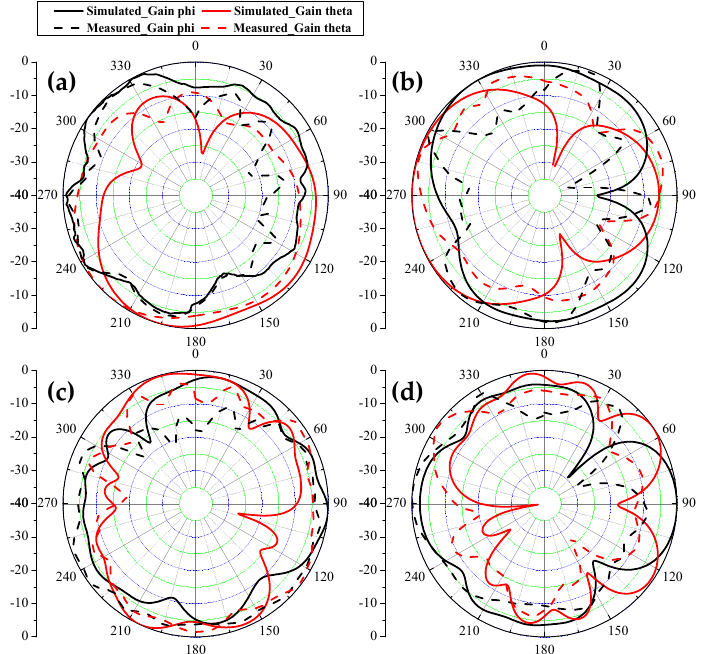
Figure 12. Measured and simulated 2D radiating patterns. ( a ) Ant. 1 is excited at 3.5 GHz, XOY plane,